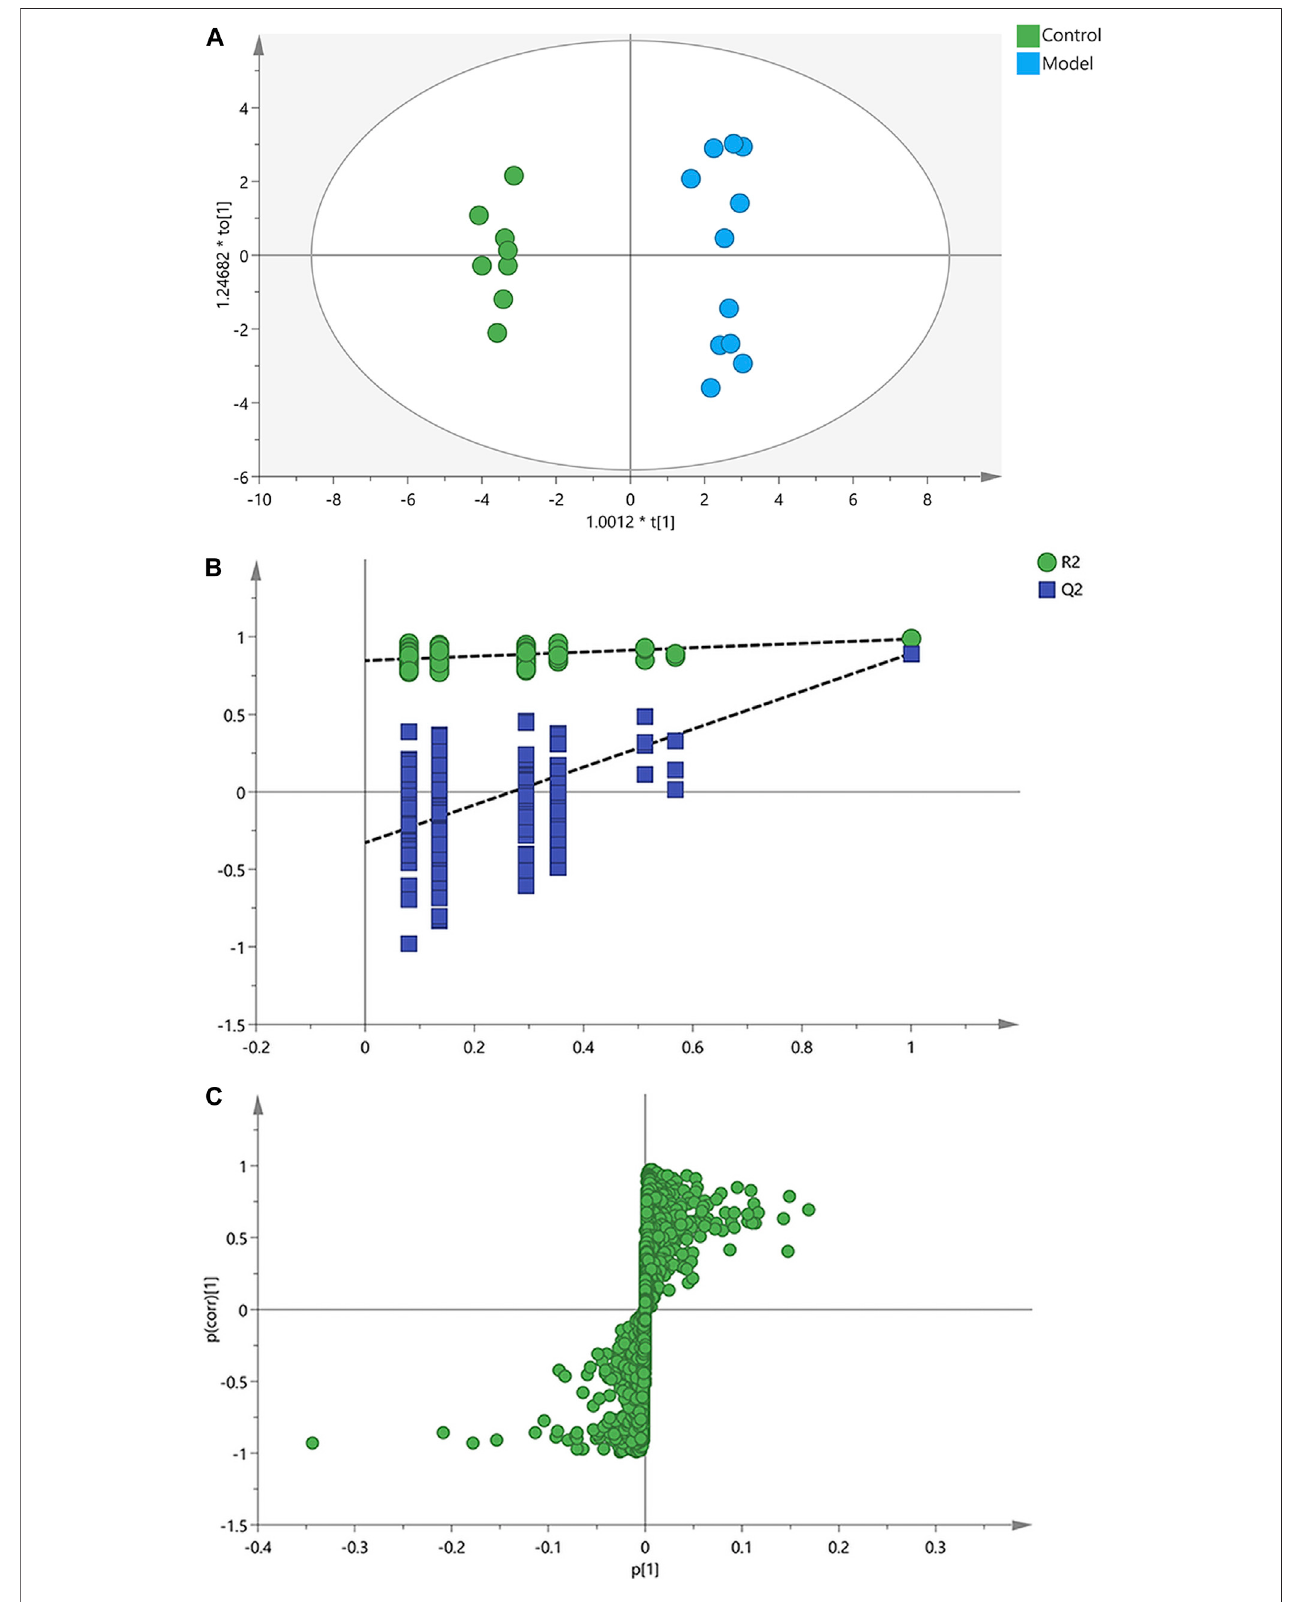
FIGURE 3 | OPLS-DA score plots, permutation test and S-plots of serum samples. (A) OPLS-DA score plots. (B) Permutation tests of OPLS-DA. (C) S-plots obtained from OPLS-DA model.